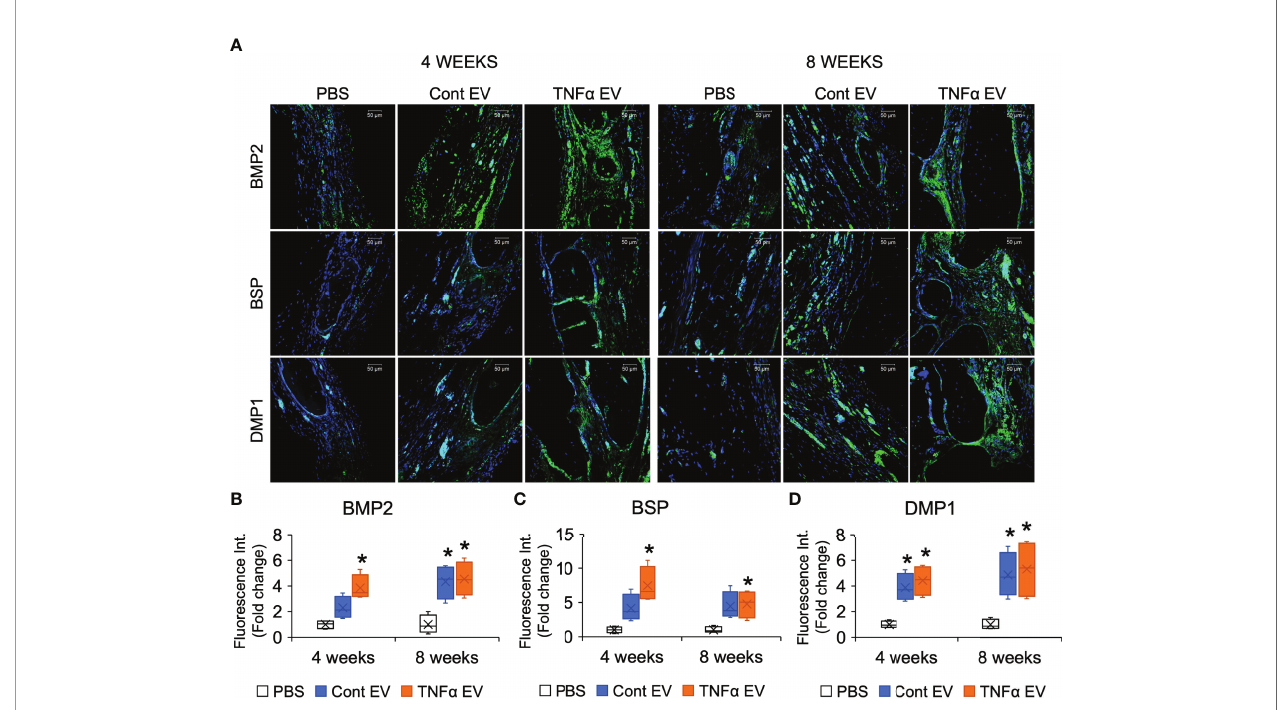
FIGURE 7 | Expression of osteogenic markers in rat calvarial defects. (A) Representative confocal micrographs representing the expression of osteogenic markers BMP2 (green), BSP (green) and DMP1 (green) in decalci fi ed calvarial sections 4- and 8- weeks post wounding. Scale bar=50 m m in all sections. (B – D) are Image J based quantitation of fl uorescence intensity of BMP2, BSP and DMP1 in the sections (n = 5) represented as fold change with respect to untreated (PBS) control. *: statistical signi fi cance (P < 0.05) with respect to PBS controls calculated by Tukey ’ s test post ANOVA. Note that while the EV treated groups showed increased expression compared to PBS control, no signi fi cant difference was observed in expression intensity between control and TNF a